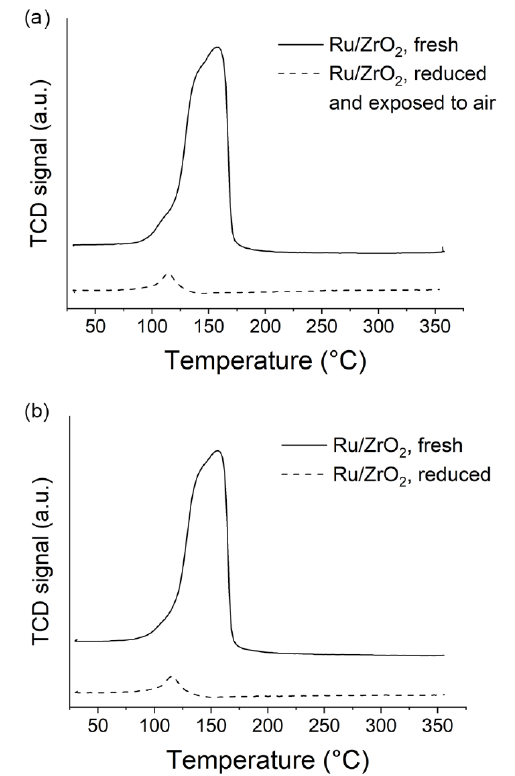
Figure 3. Temperature-programmed reduction (TPR) profiles of Ru / ZrO 2 catalyst before and after reduction at 350 °C for 2 h. ( a ) The catalyst was exposed to air for 20 min after reduction, ( b ) the catalyst was not exposed to air.